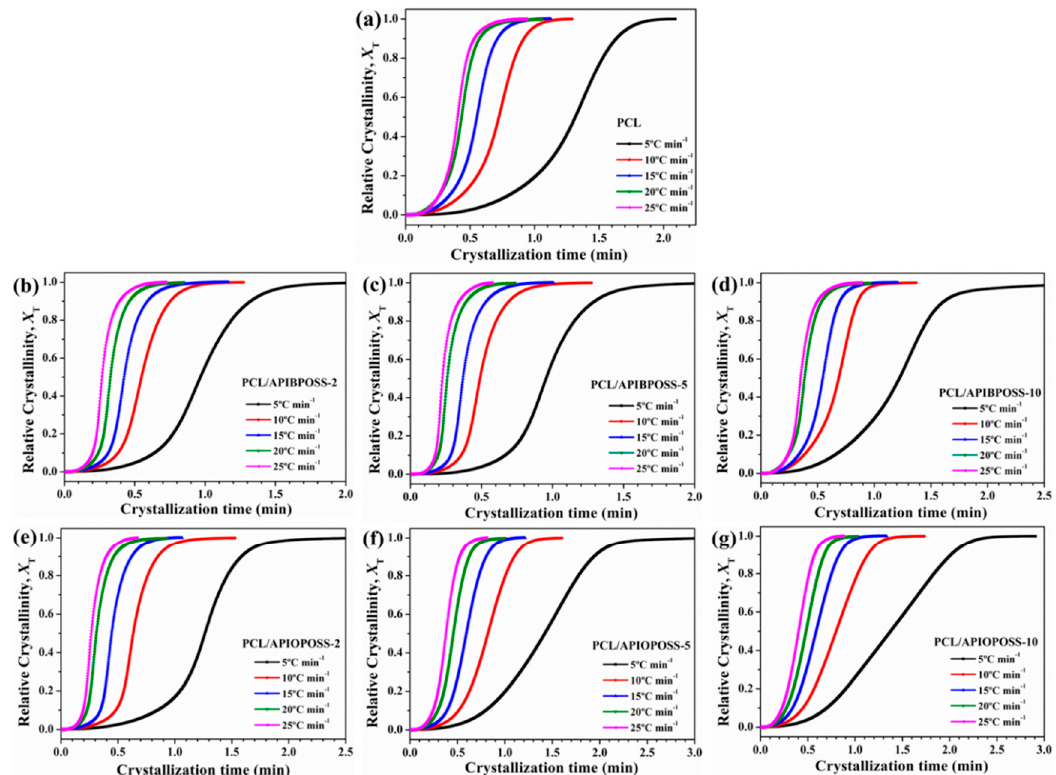
Figure 9. Development of relative crystallinity with time for non-isothermal crystallization of ( a ) PCL, ( b – d ) PCL / APIBPOSS nanocomposites, ( e – g ) PCL / APIOPOSS nanocomposites at various cooling rates.